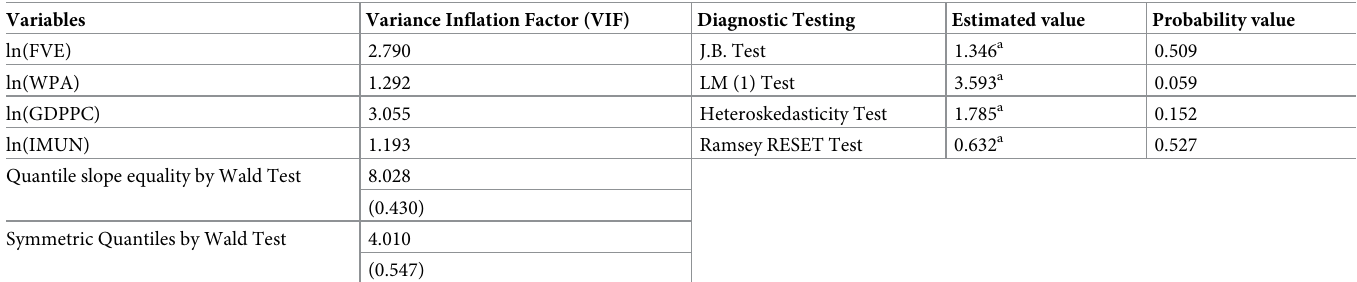
Table 5. Diagnostic